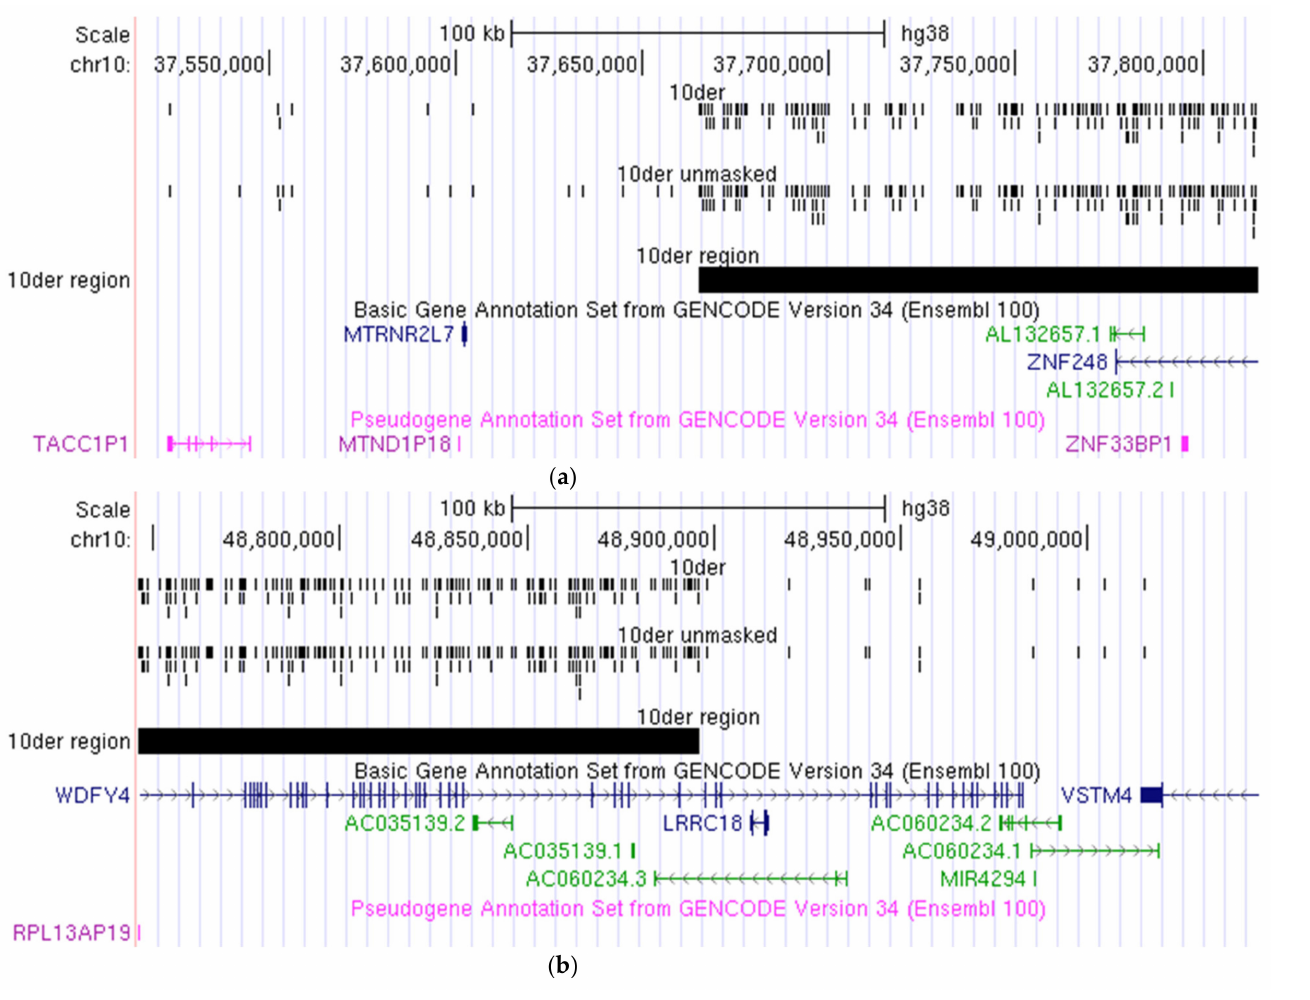
Figure 10. Localization of breakpoints in ( a ) 10p11.21; and ( b ) 10q11.23 in the sSMC according to NGS of the microdissected single-copy